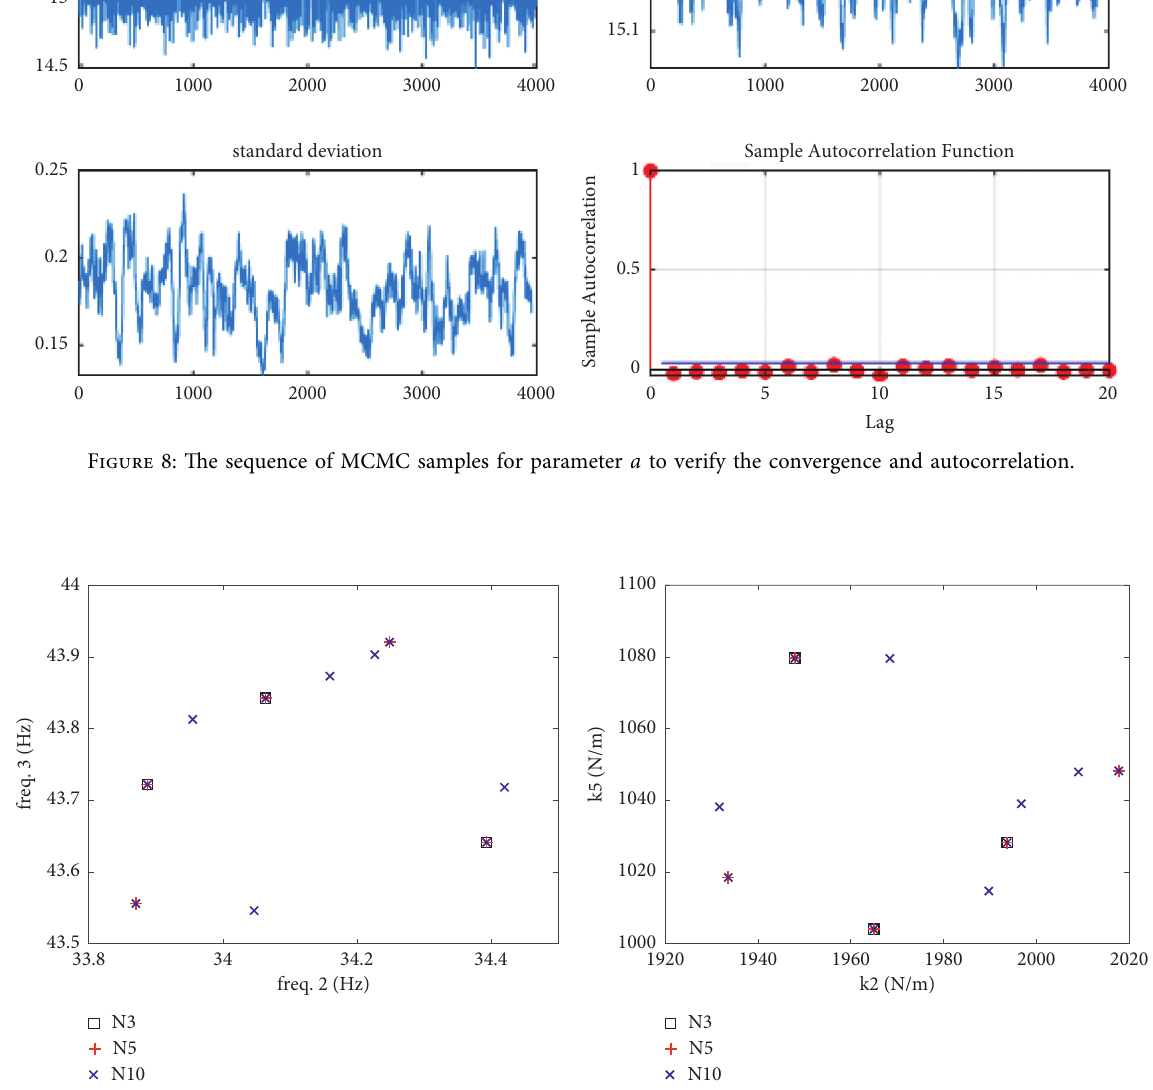
Figure 9: Virtual experimental frequency samples for case study 2 (a) and corresponding samples of spring stiffness (b).